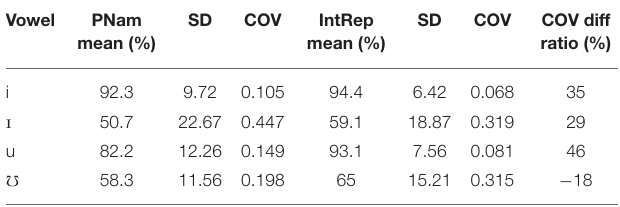
TABLE 2 | Mean intelligibility by vowel and task (all